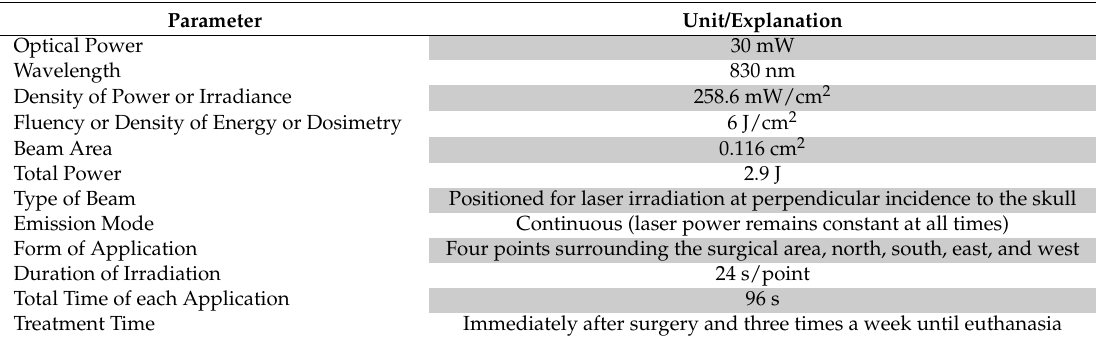
Table 1. Therapeutic parameters of the photobiomodulation therapy used in this